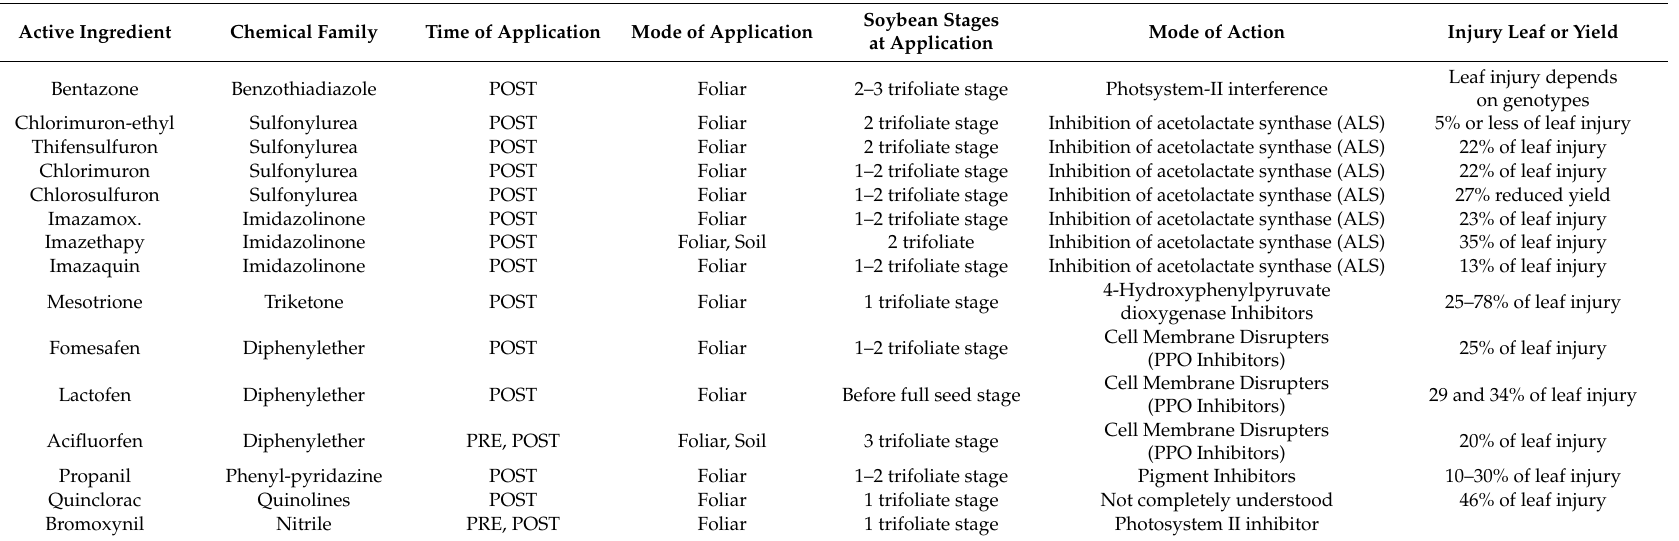
Table 1. List of PRE and POST herbicides that commonly used to control broadleaf weed management in